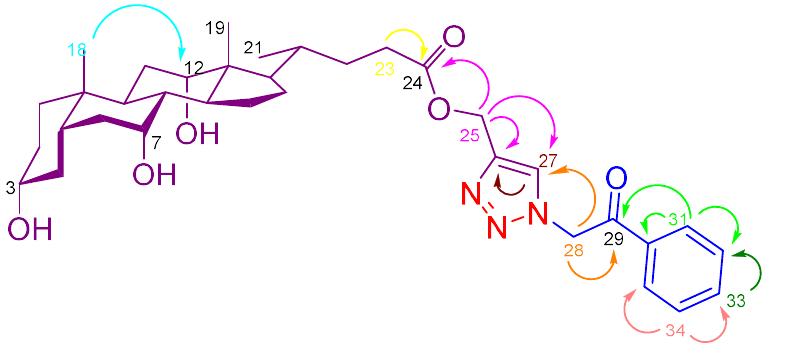
Figure 2. Selective correlations based on 1 H, 13 C-HMBC spectrum of 6aa . Table 1. 1 H and 13 C NMR assignments for the representative proton/carbon signals of 6aa . S.